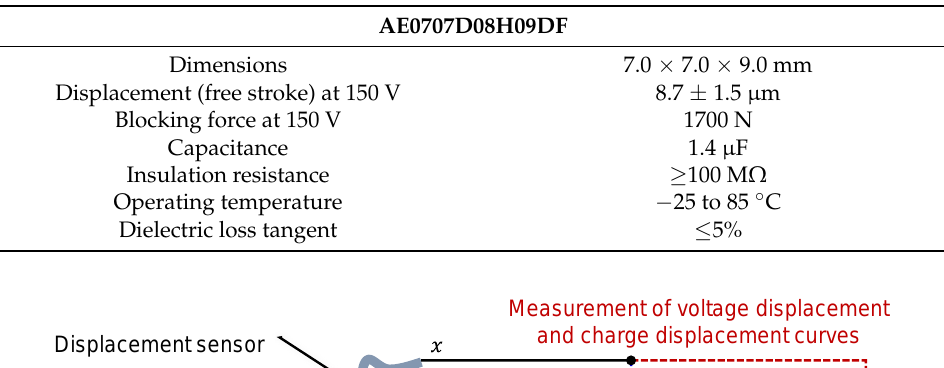
Table 2. Specifications of the piezoelectric stack actuator.